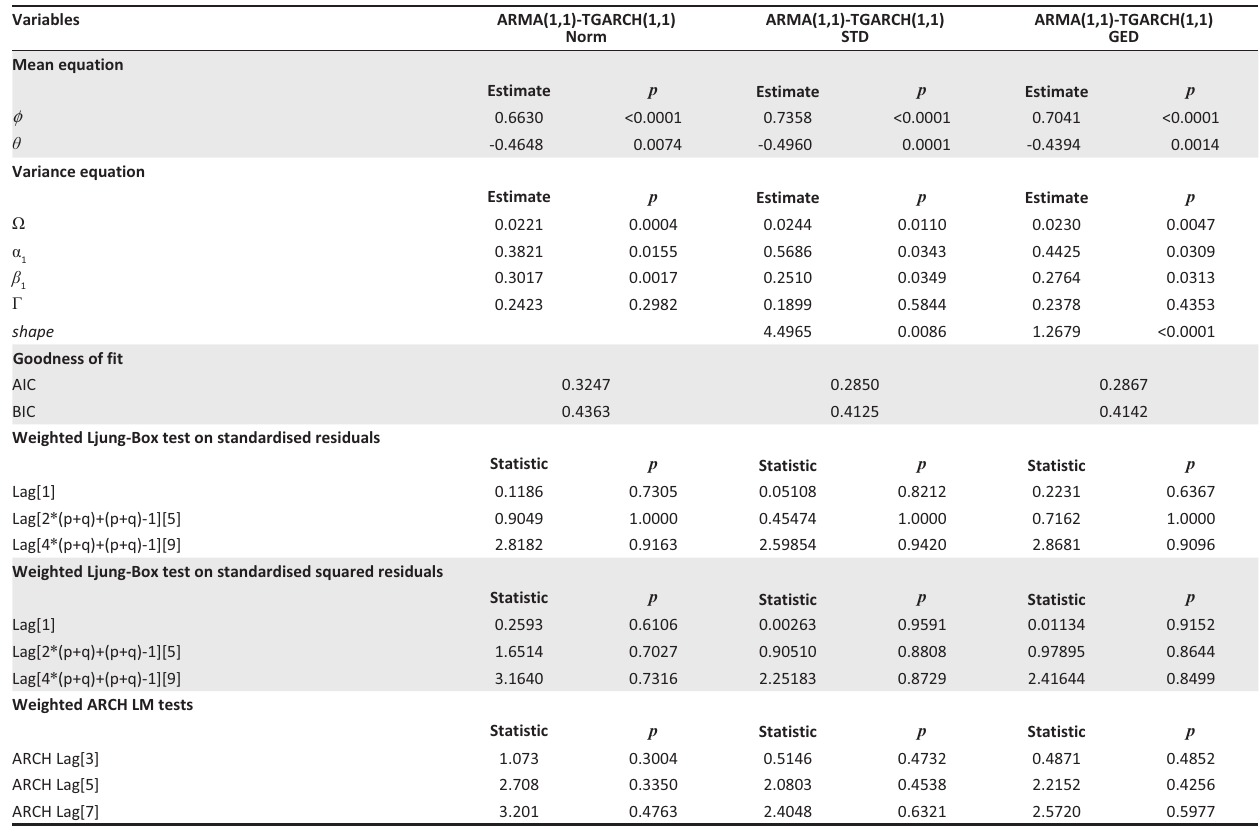
ARMA, autoregressive moving average; TGARCH, threshold generalised autoregressive conditional heteroscedasticity; GED, generalised error distribution; ARCH, autoregressive conditional heteroscedasticity; LM, Lagrange Multiplier; AIC, Akaike information criterion; BIC, Bayesian information criterion. FIGURE 5: ARMA(1,1)-TGARCH(1,1)